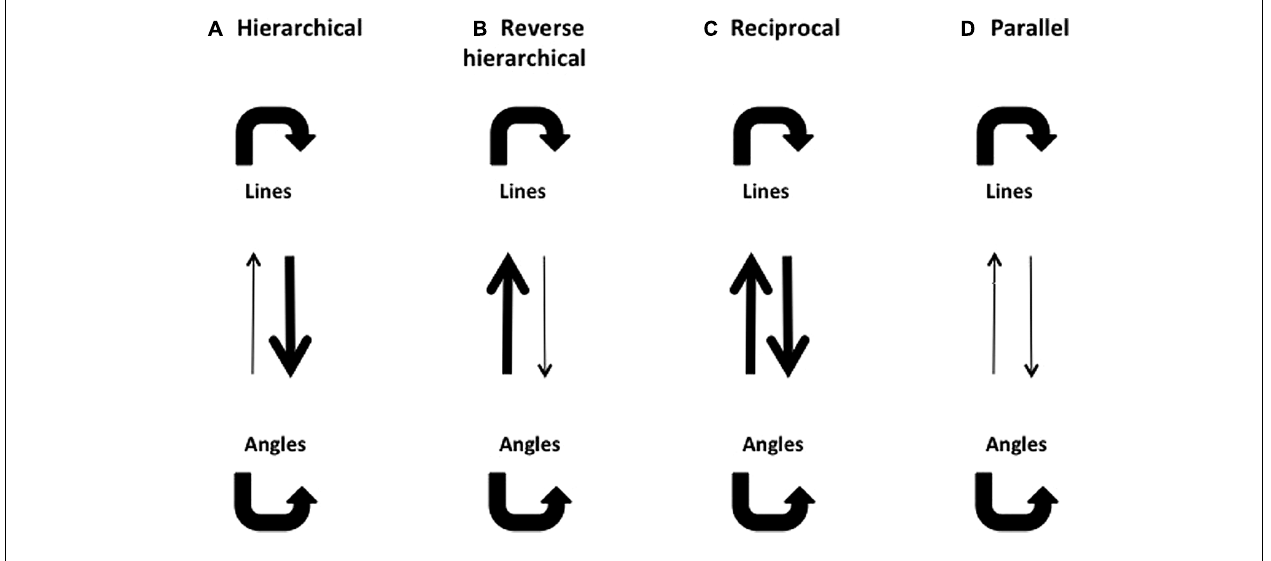
angles should be able to mask lines, but lines should not be able to mask angles. (C) A reciprocal model predicts that lines and angles should be able to mask each other effectively. (D) A parallel model predicts that neither lines nor angles should be able to mask each other